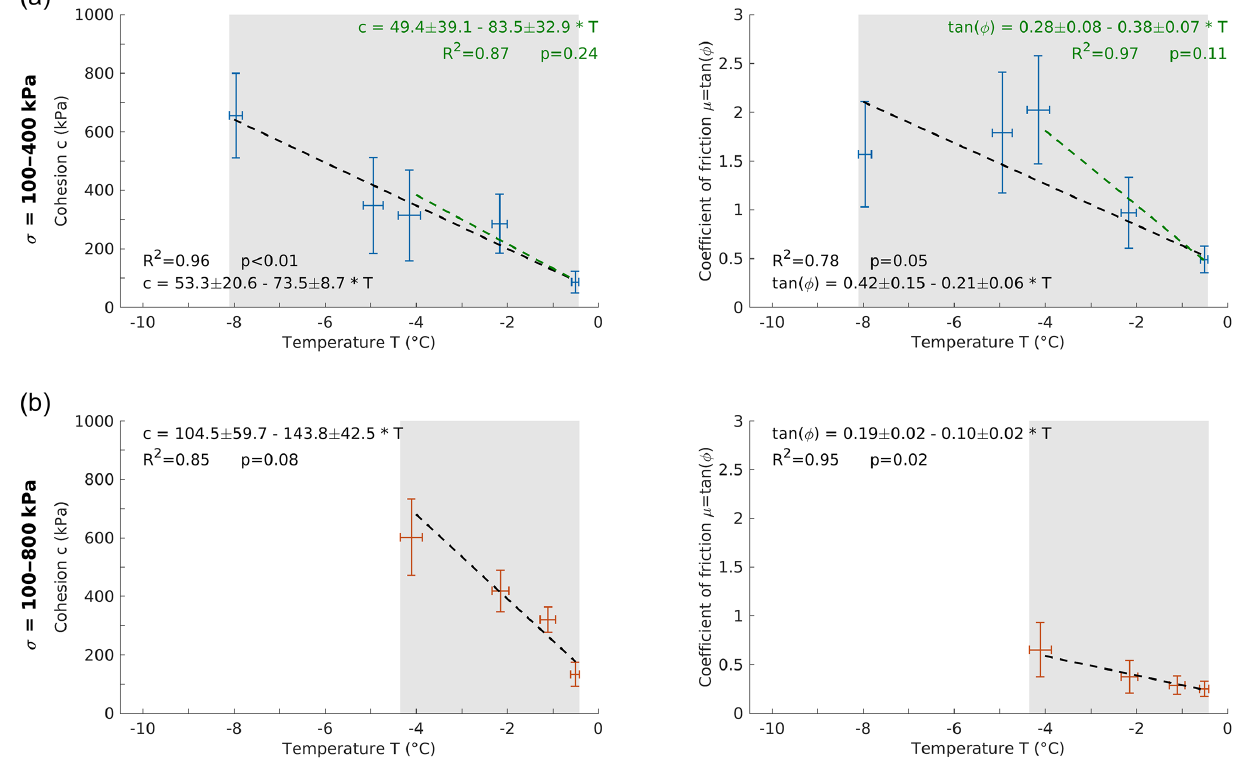
Figure 7. Cohesion and friction of ice-filled rock joints as a function of temperature for significant temperature levels with a statistical significance level of p ≤ 5%. The crosses display the means and standard deviations of rock temperature and cohesion or friction, grouped by the tested temperature classes. (a) Tests at normal stresses at 100–400kPa and temperatures at − 8 to − 0 . 5 ◦ C (blue crosses). (b) Tests at normal stresses at 100–800kPa and temperatures at − 4 to − 0 . 5 ◦ C (orange crosses). The dashed lines represent the linear regression functions, which were inversely weighted with the squared standard errors. The green regression lines in (a) refer to a temperature range from − 4 to − 0 . 5 ◦ C. The grey areas represent the valid temperature range for the respective